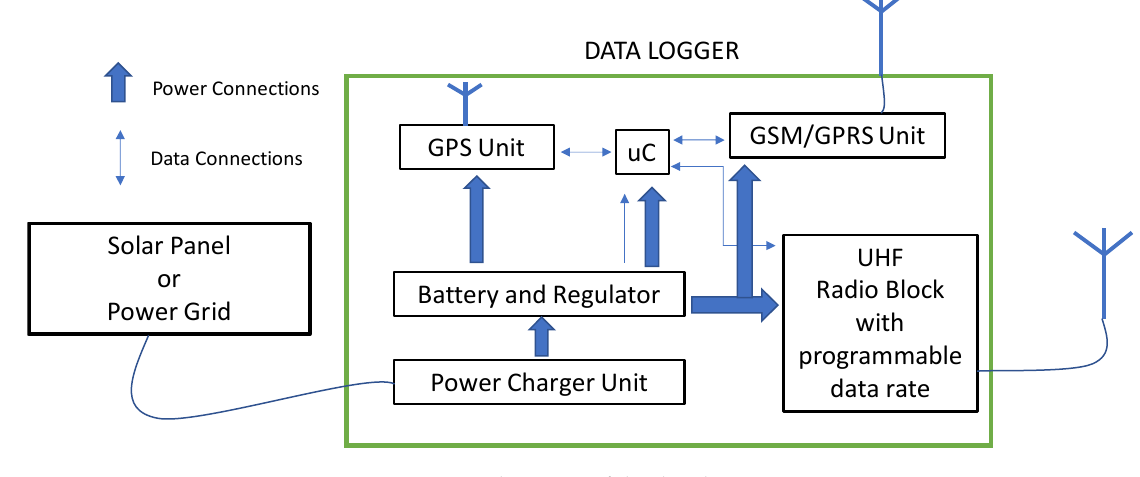
Figure 5. Architecture of the data logger.